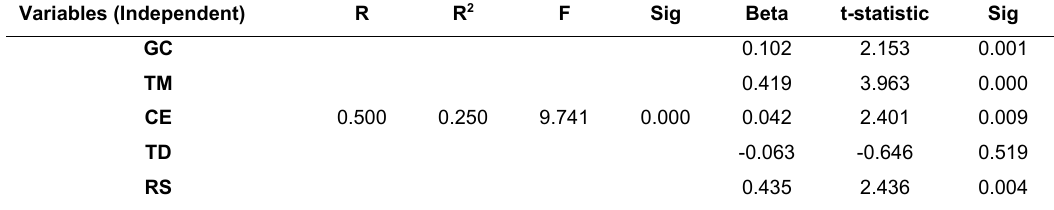
Table 9. Hypothesis test (H 2 ): Dependent variable: Continence commitment.